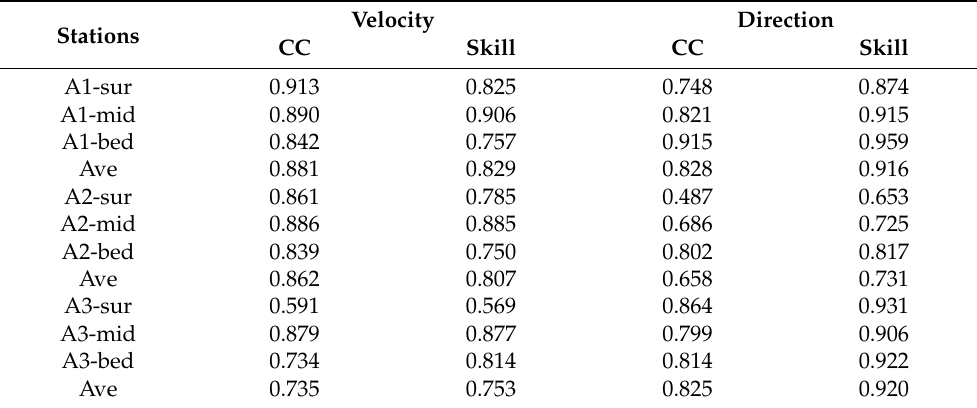
Figure 5. The comparison between computed (red dots) and measured currents (black solid line): ( a ) represents station A1, the time is in hours from 10:00 on 4 July 2007 to 10:00 on 5 July 2007; ( b ) represents station A2, the time is in hours from 06:00 on 3 July 2007 to 07:00 on 4 July 2007; ( c ) represents station A3, the time is in hours from 10:00 on 29 June 2007 to 22:00 on 29 June 2007. ( i ) Surface current velocity; ( ii ) middle current velocity; ( iii ) bottom current velocity; ( iv ) surface current direction; ( v ) middle current direction; ( vi ) bottom current direction. Table 3. Correlation coefficient and skill score of each measured site.